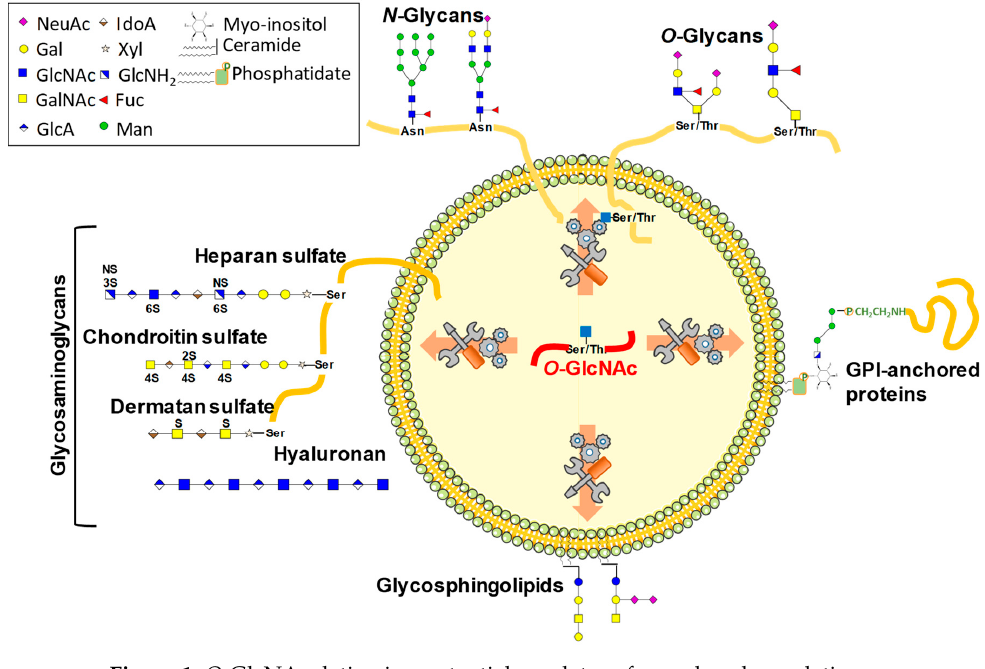
Figure 1. O -GlcNAcylation is a potential regulator of complex glycosylations.